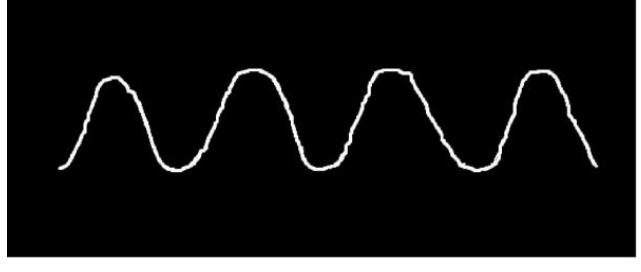
Figure 6. Test image of the curve